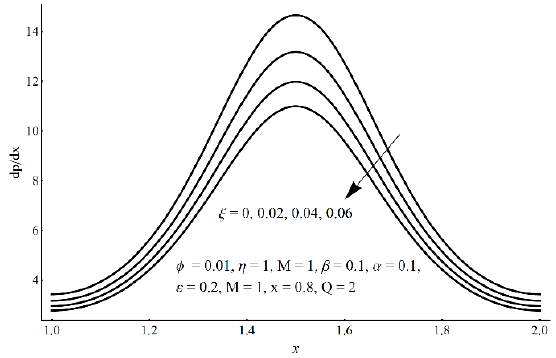
Figure 8. Pressure gradient at various values of variable ξ .